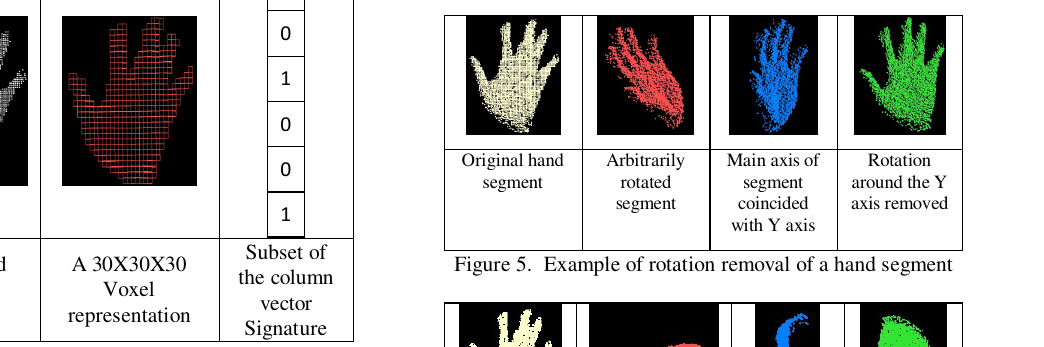
Figure 4. Generation of a hand segment signature